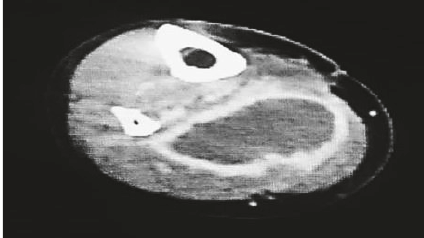
Figure 3: Contrast-enhanced CT on day 32.